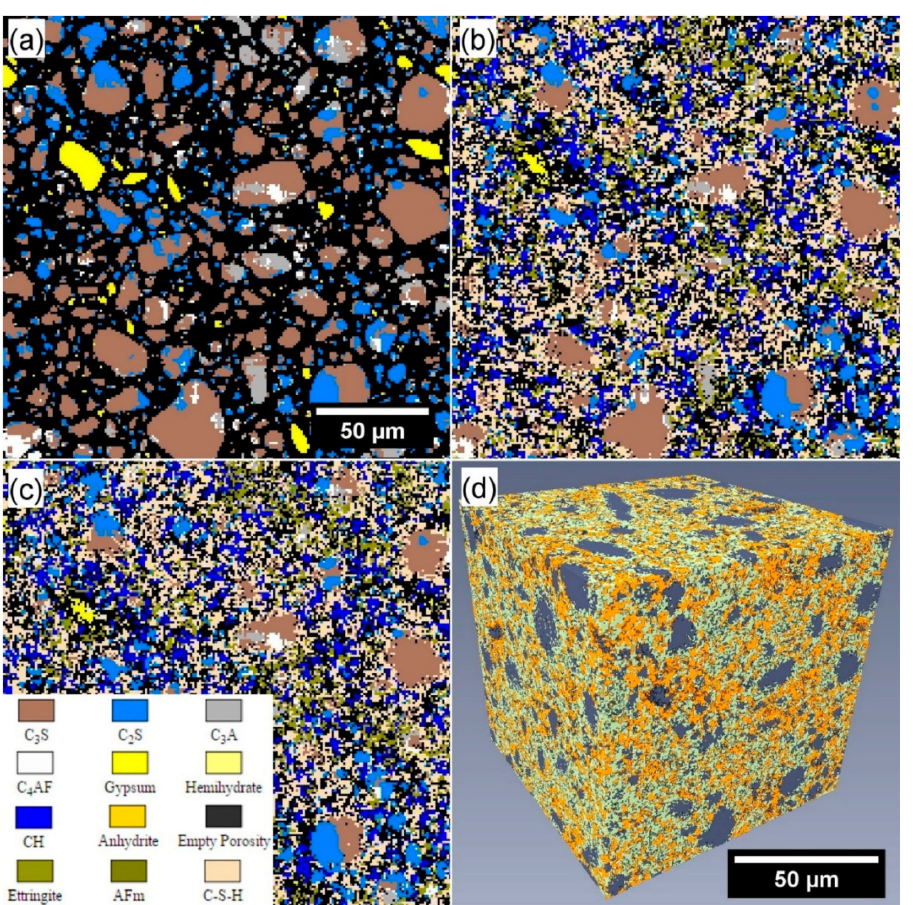
Figure 8. ( a – c ) Colour-coded VCCTL microstructural slices after ( a ) 0 hours, ( b ) 7 days, and ( c ) 28 days of simulated hydration of the virtual cement V 1 . ( d ) Reconstructed volume rendering of the segmented microstructure at 28 days of hydration, within the Avizo software